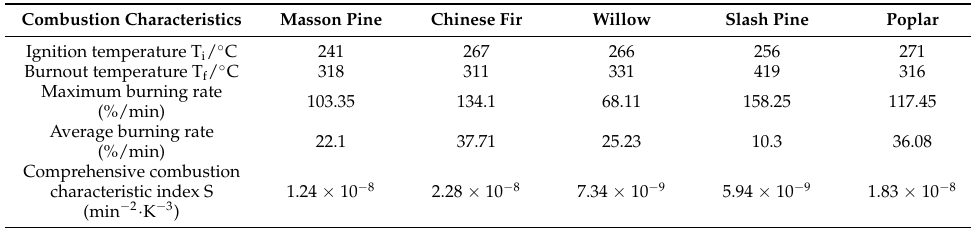
Table 3. Comprehensive combustion characteristic